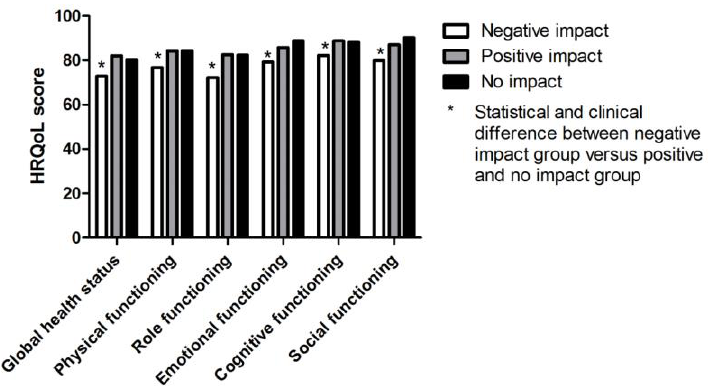
Figure 2. Mean HRQoL scores by impact of diagnostic interval on HRQoL.